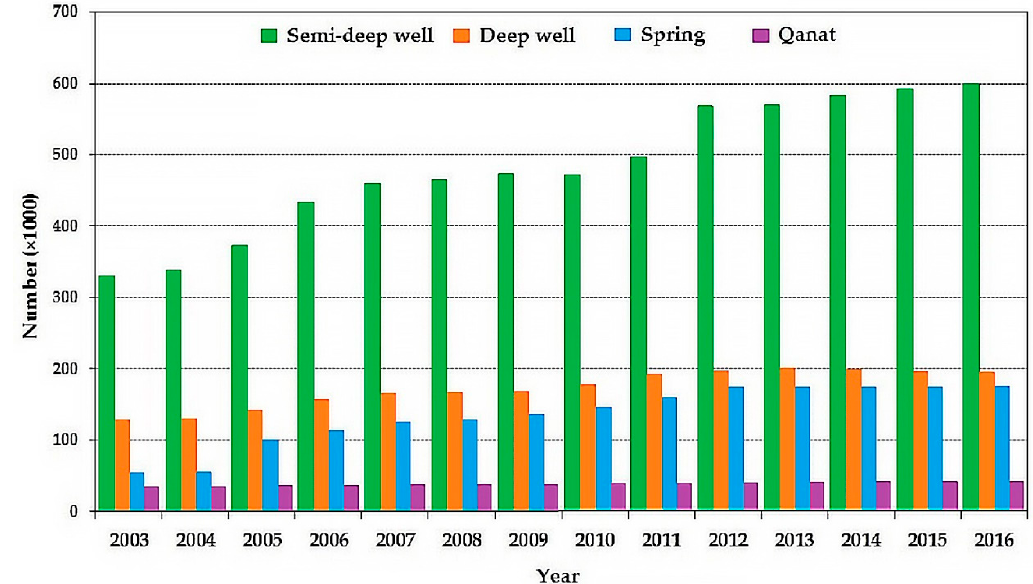
Figure 1. The number of deep and semi-deep wells, qanats, and springs in the period of 2003 to 2016 in Iran [32].